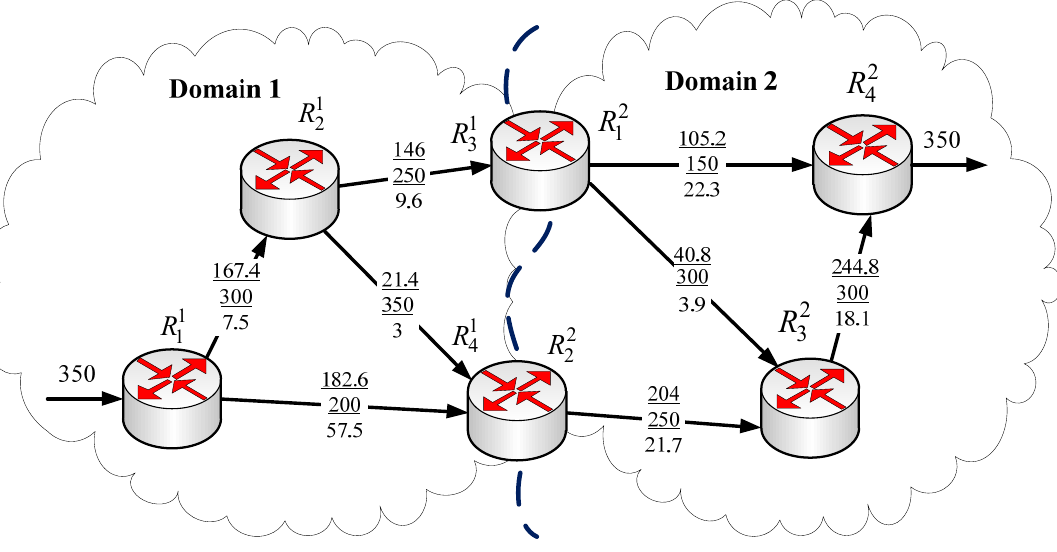
Figure 10. Final (coordinated) solution of inter-domain QoS routing problem (after the third iteration of the coordination procedure) following the normalized requirements (24).